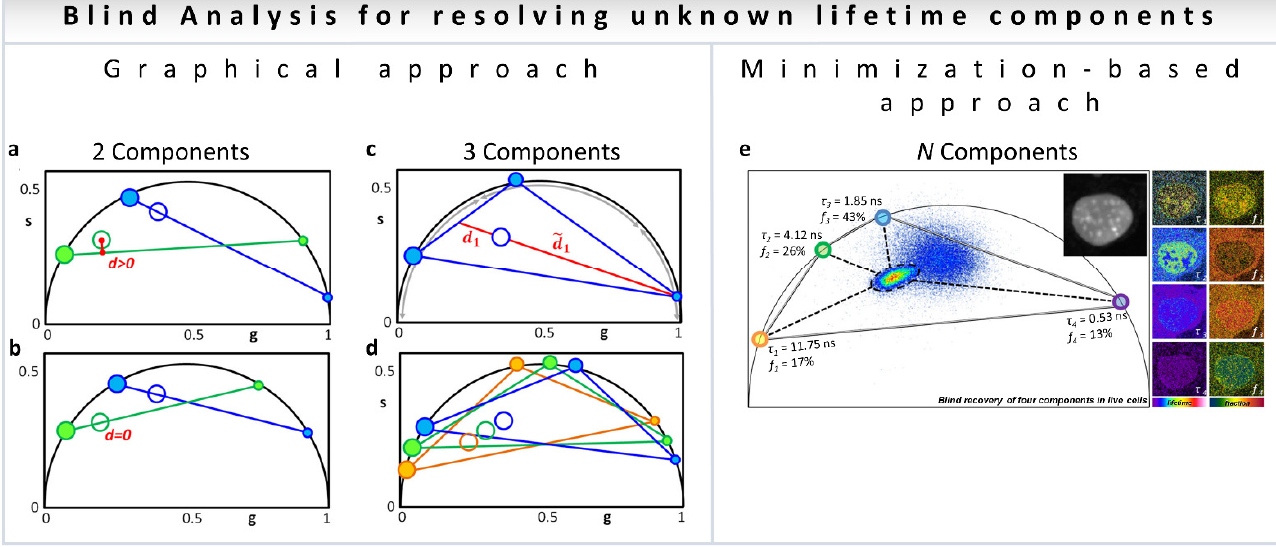
Figure 3. Blind component analysis for resolving unknown lifetimes in phasor plot—assuming the components have mono-exponential lifetimes. ( a , b ) Graphically finding two unknown lifetime components and their relative fractional intensities. ( a ) Universal circle is scanned for candidate components. For each position of the first component (small blue dot), a line is drawn through the data point (blue empty circle) and the second point is found where the blue line meets the universal circle (large blue filled circle). The second harmonic ( h 2) for the candidate components are obtained mathematically: small green dot and the large green filled circle. A line is drawn through them (green line). ( b ) Solution is the only lifetime pair that has the lines (blue and green) going through the data points for the two harmonics, that is, when the distance from the green line to the green empty circle is zero. The relative fractions are obtained by the ratios between the distances from the filled dots to the empty circles on both sides of the line. ( c , d ) Finding the three lifetime components in the universal circle. ( c ) Schematic configuration of three components generating a data point (ring in the middle). As an example, the ratio between the two distances is related to the intensity fraction ( f ) of the component located in the short lifetime region; f 1 = d 1/( d 1 + d ̃ 1). In the same manner, the other two fractions can be obtained for the other two components. ( d ) Solution to the three-component problem is the only combination of components such that the three fractions are the same in each of the triangles composed of the three harmonics (blue–green–orange). The short, medium, and long lifetime components in each harmonic are depicted by increasingly larger filled circles. ( e ) Minimization-based approach. This general algorithm can technically be solved the problem to N number of components depending on noise propagation in the multiple harmonics. (Panels a – e adapted with permission from [38]).